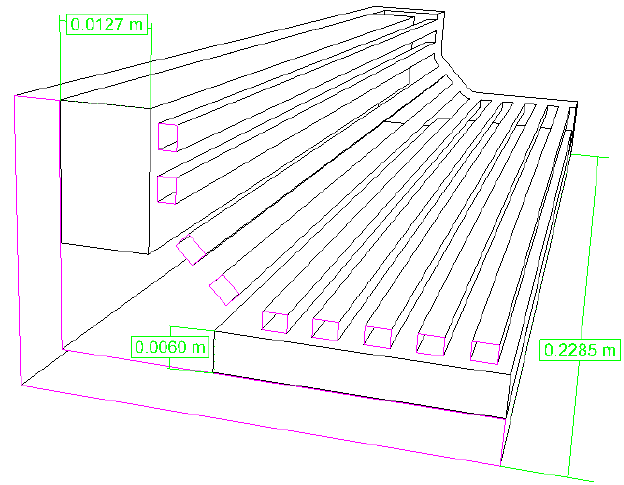
FIG. 18. (Color) IR absorber. One quarter.